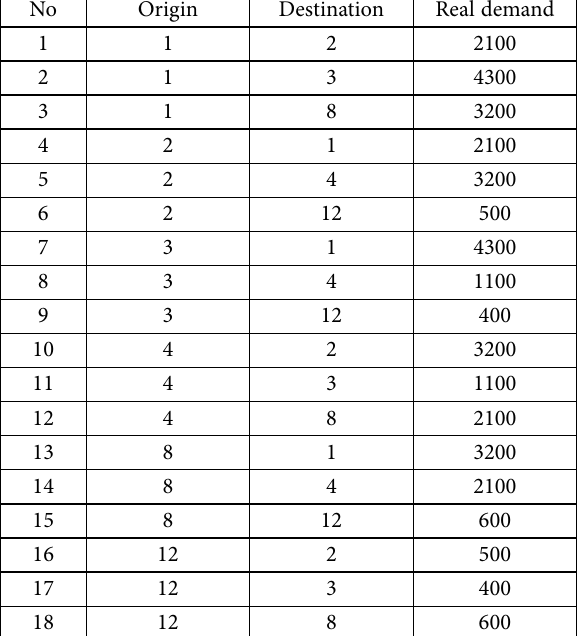
Figure 2. The Nguyen–Dupuis network, showing the nodes and links Table 1. O–D pairs and associated demands in the Nguyen–Dupuis network